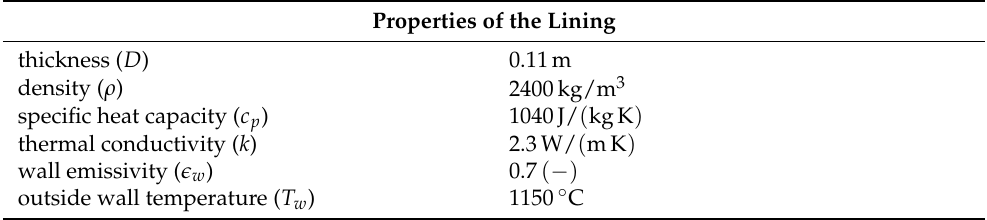
Table 1. Geometrical and material properties of the thermally insulating lining and boundary conditions imposed.